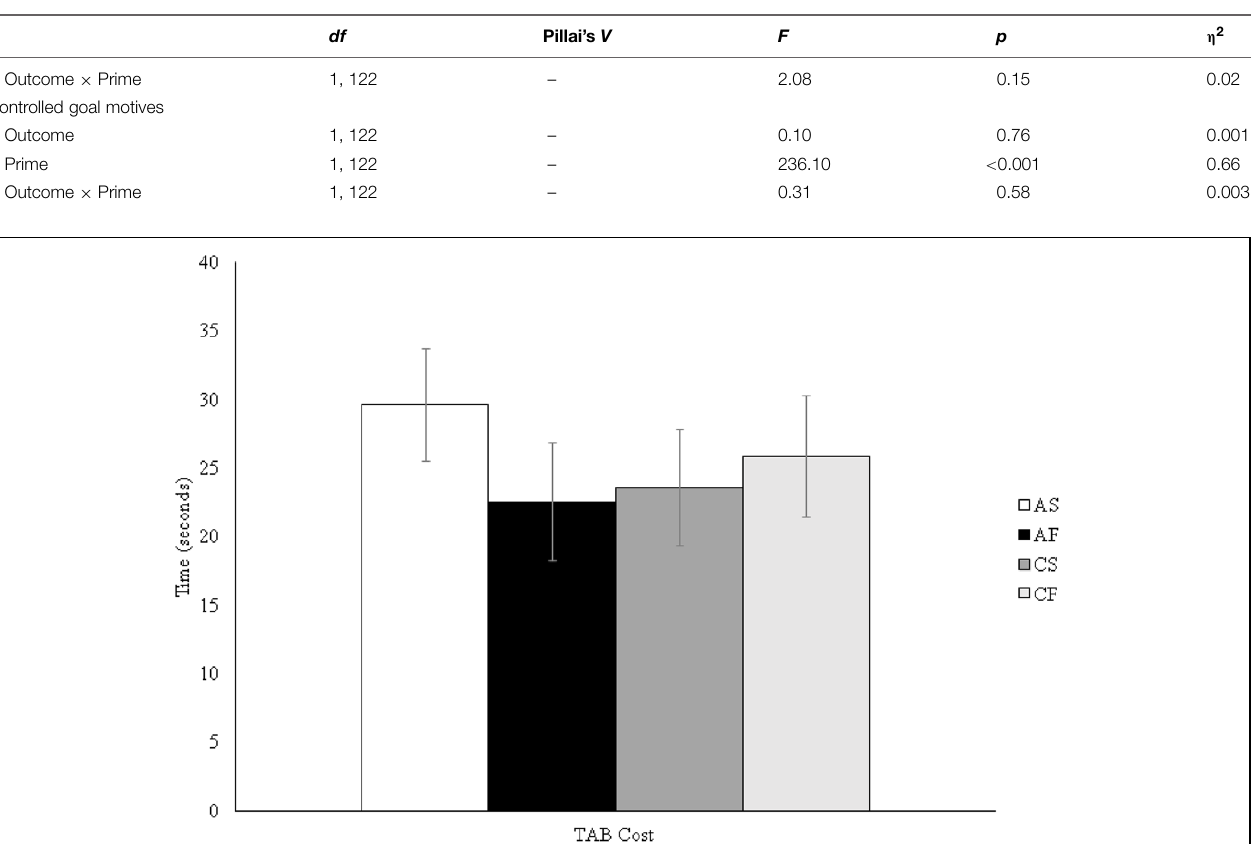
= 0.01]. The AST and physical performance task p = 0.19, η 2 p findings are displayed in Figures 2 and 3